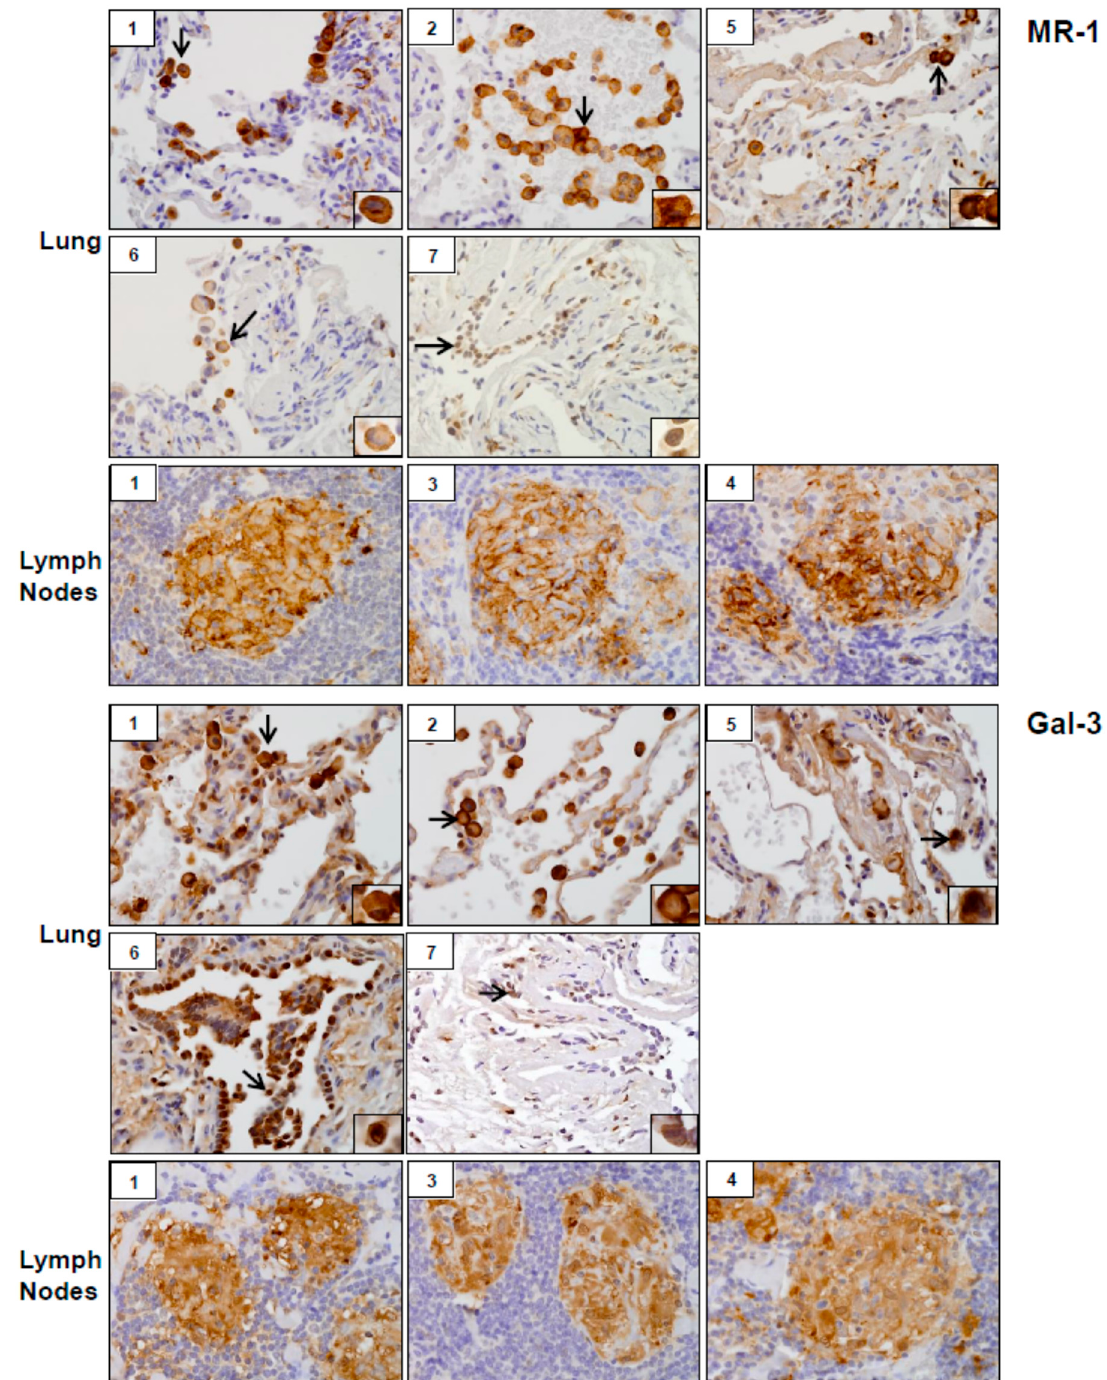
Figure 7. Mannose receptor (MR)-1 and Galectin (Gal)-3 expression in lung and/or lymph nodes collected from WTC rescue and recovery workers. Sections were immunostained with antibody to MR-1 or Gal-3. Binding was visualized using a DAB peroxidase substrate kit. One representative section from each patient is shown. Inset, patient number. Magnification, 60×; arrows, alveolar macrophages.